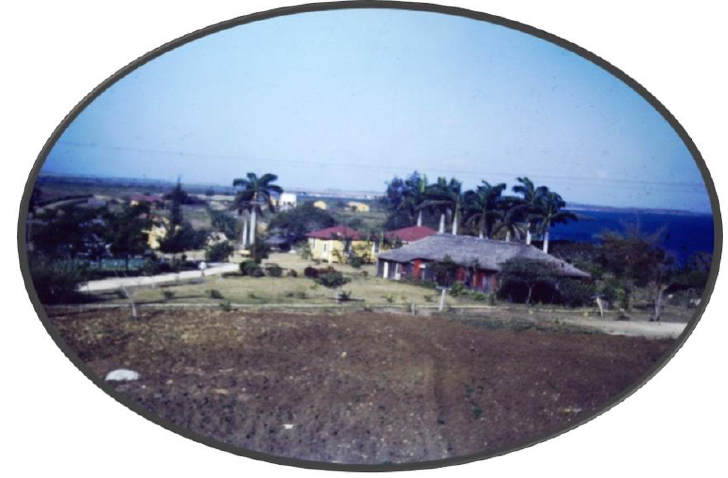
Figure 3. La Granja, Late 1940s. 40